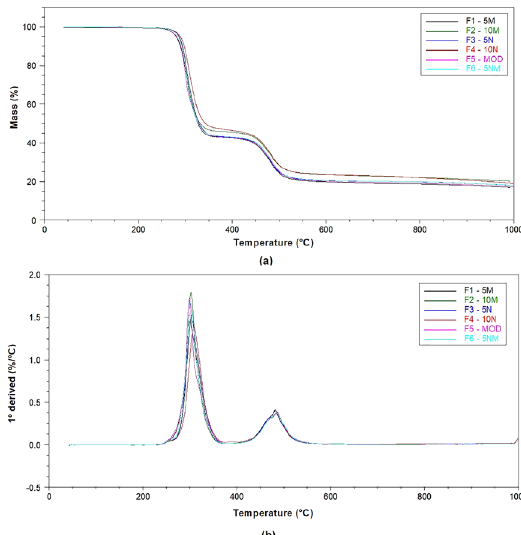
Table 5. Glass transition temperature for formulations with micro and measured through DMA from the loss module nano-CaCO 3